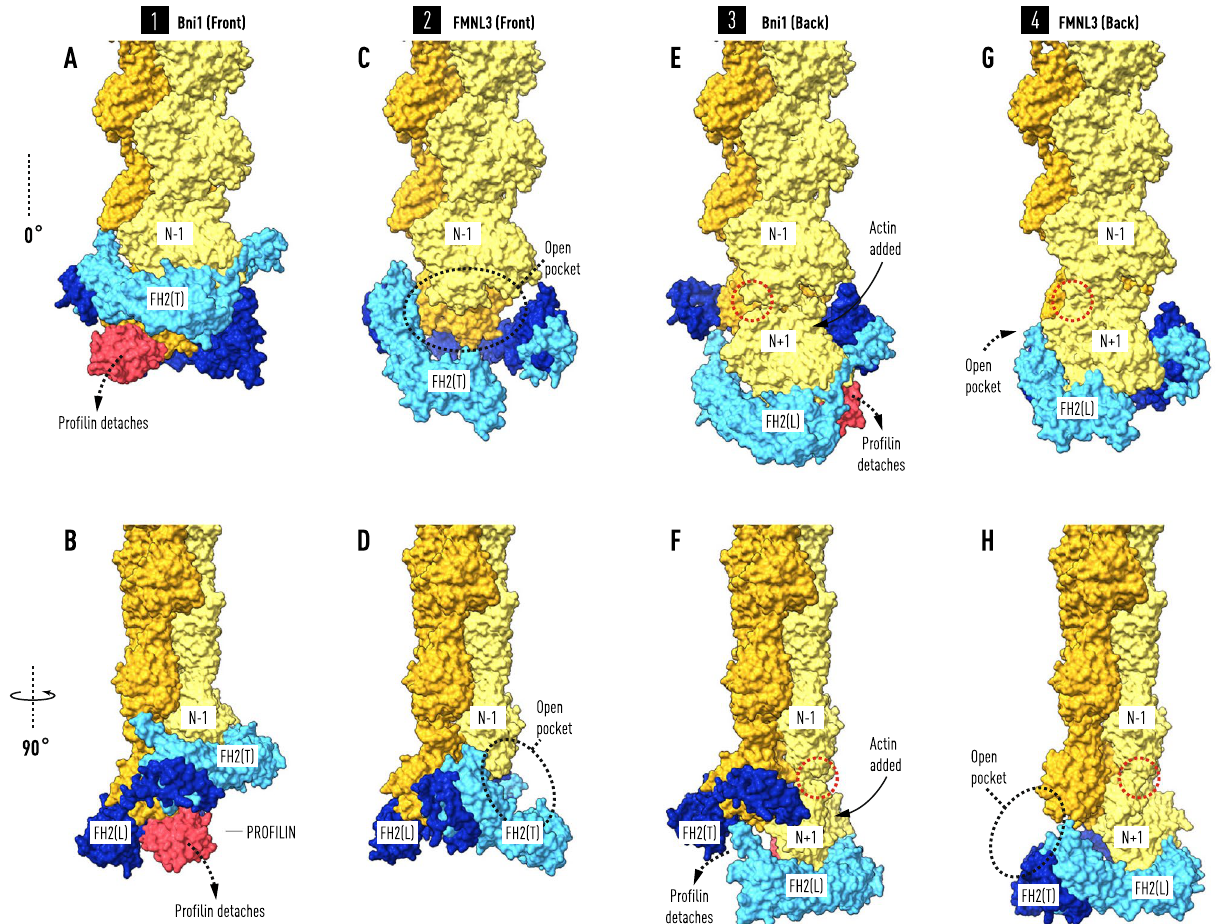
Figure 5. Profilin controls the timing of the elongation reaction. The front and back views of the two co-crystal structures afford views of the interaction between FH2 domains and actin at four steps (A–B, C–D, E–F, G–H) during the elongation reaction. Panels ( A ) and ( B ) show two orientations of the Bni1 FH2-actin heterodimer (modeled as in Fig. 1) stabilized by the binding of profilin–actin(N) to FH2(L). Actin(N) and actin(N−2) are coplanar. In panels ( C ) and ( D ) profilin has been released from actin(N) during the migration of FH2(T) towards the barbed end creating a binding pocket for actin(N+1). Actin(N) rotates 13° and docks into the helical niche formed by actin(N−1) and actin(N−2). In panels ( E ) and ( F ) the insertion of profilin–actin(N+1) results in the coplanar alignment of actin(N+1) with actin(N−1). In panels ( G ) and ( H ), following the release of profilin, actin(N+1) rotates and docks onto the barbed end of the filament with the closing of a small gap (indicated by red dotted circle) between actin(N−1) and actin(N+1). Note that to model the four steps in the reaction sequence as viewed from the front, the colors of FH2(L) and FH2(T), as well as those of the filament strands, have been reversed in ( E , F ) and ( G , H ) from the front view structures on the left ( A , B and C , D ). To model the addition of the new subunit N+1, N (not labelled) in panels ( A , B ) and ( C , D ) is relabeled N+1 on panels ( E , F ) and ( G , H